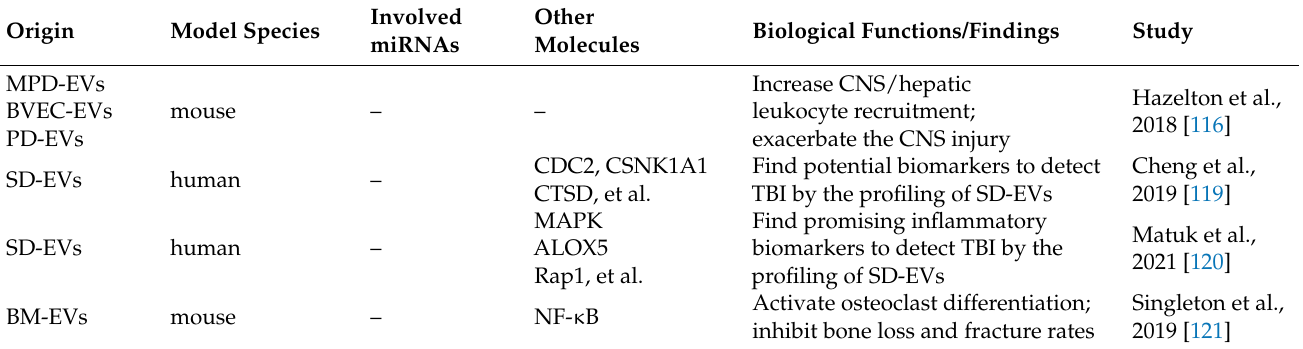
Table 7. Other cell-derived Exos/EVs and exosome-derived-miRNA studies in